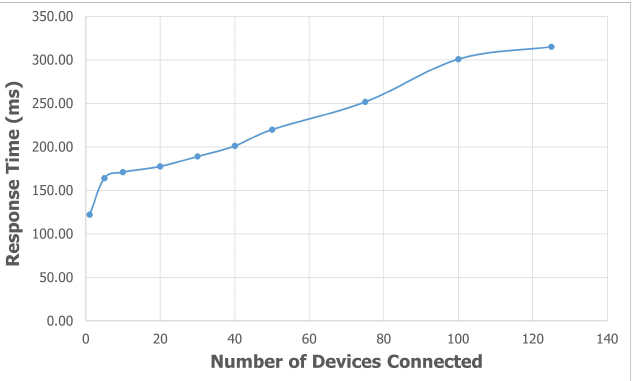
Figure 19. Average response time for MQTT communications with different numbers of devices.